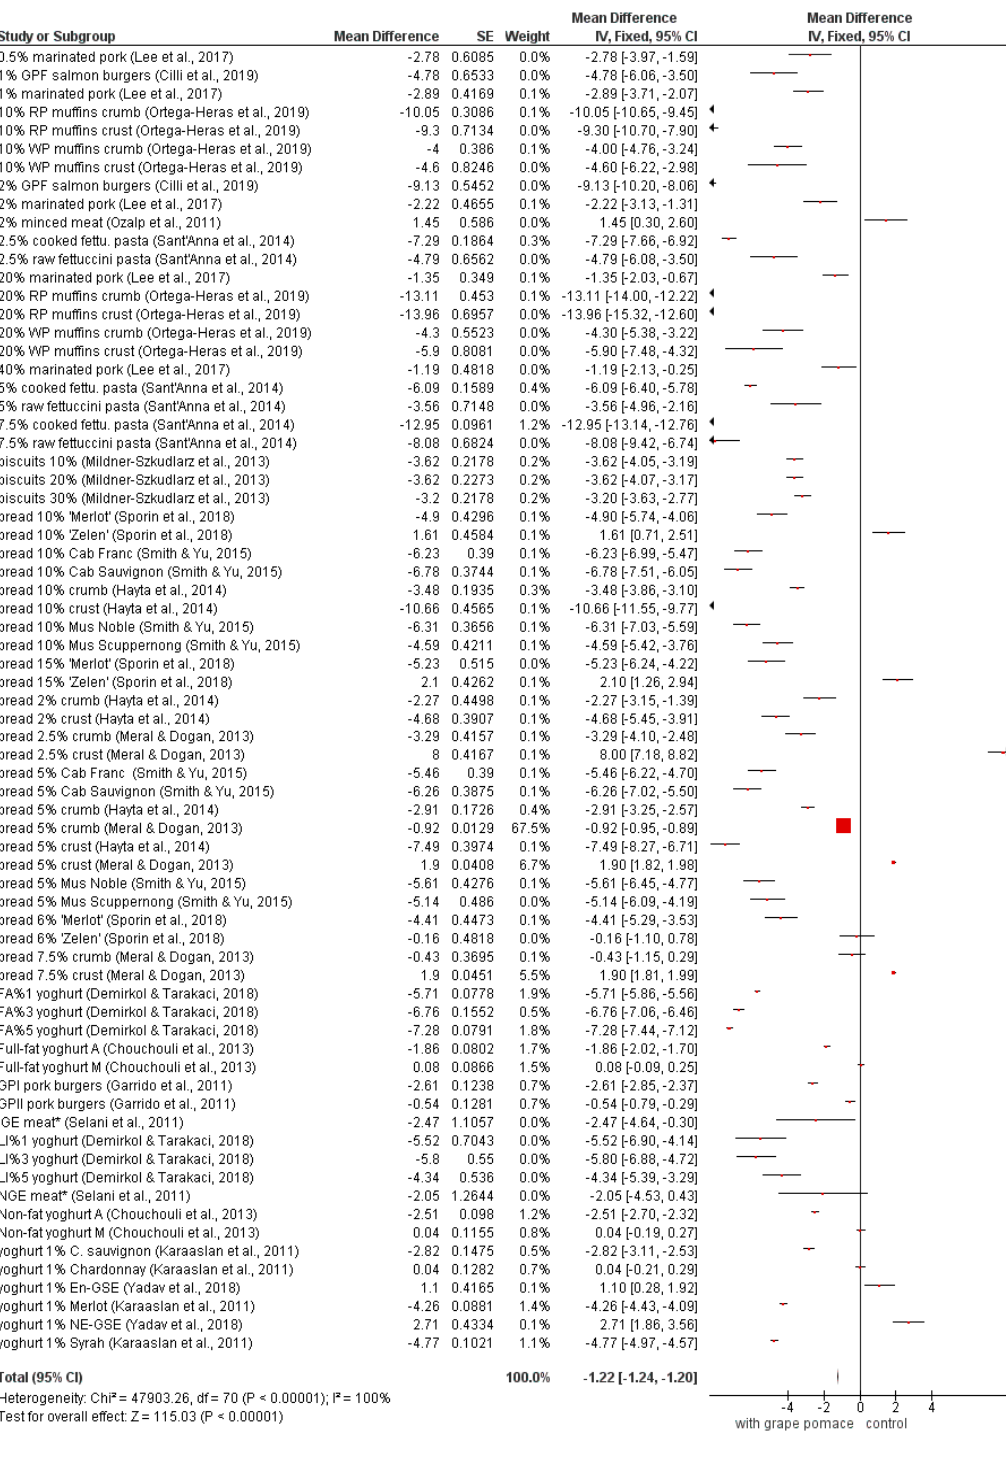
Figure 5. Meta-analysis of b value in fortified products [13,19,21,23,43,46–48,53,60,63,64,69,70,72,73]; *